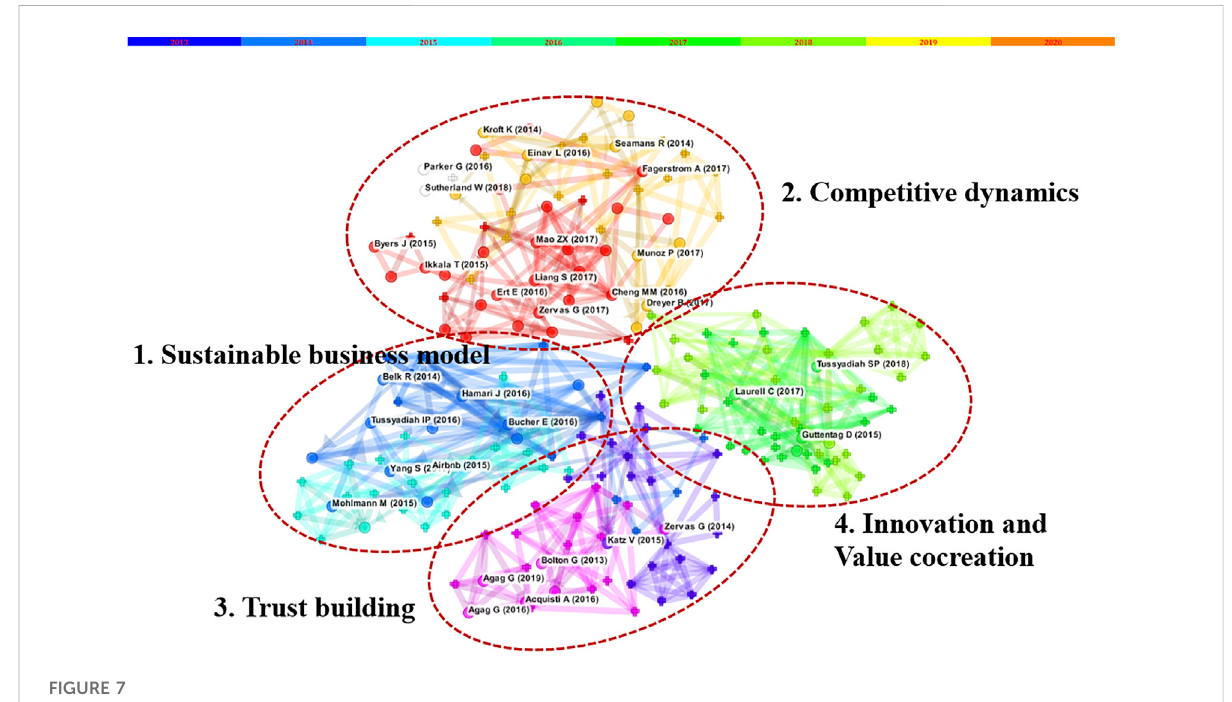
FIGURE 7 Visualized co-citation